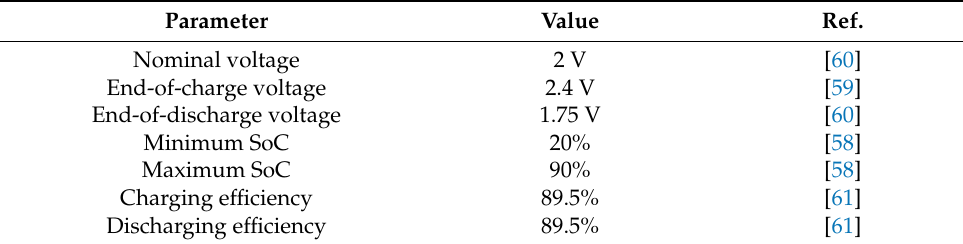
Table 5. Design parameters of the lead-acid battery. Parameter Value